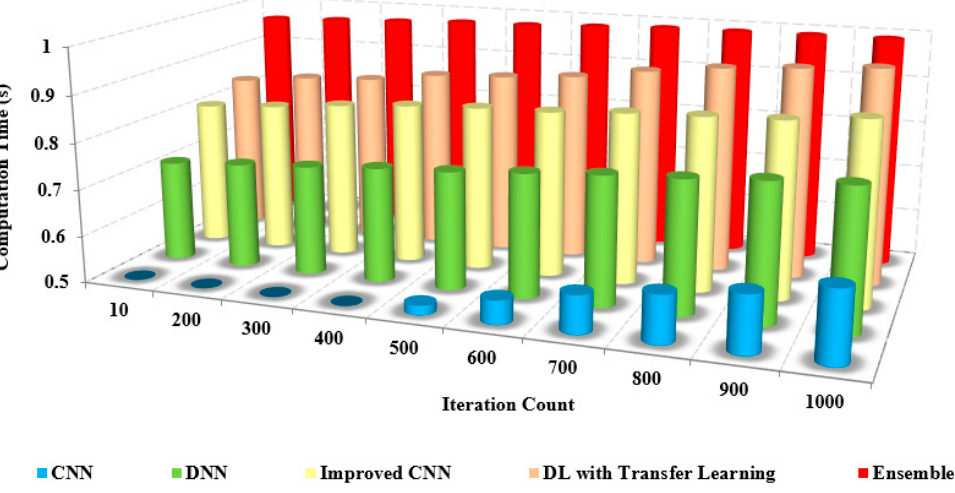
Figure 14. Iteration count vs. computation time.